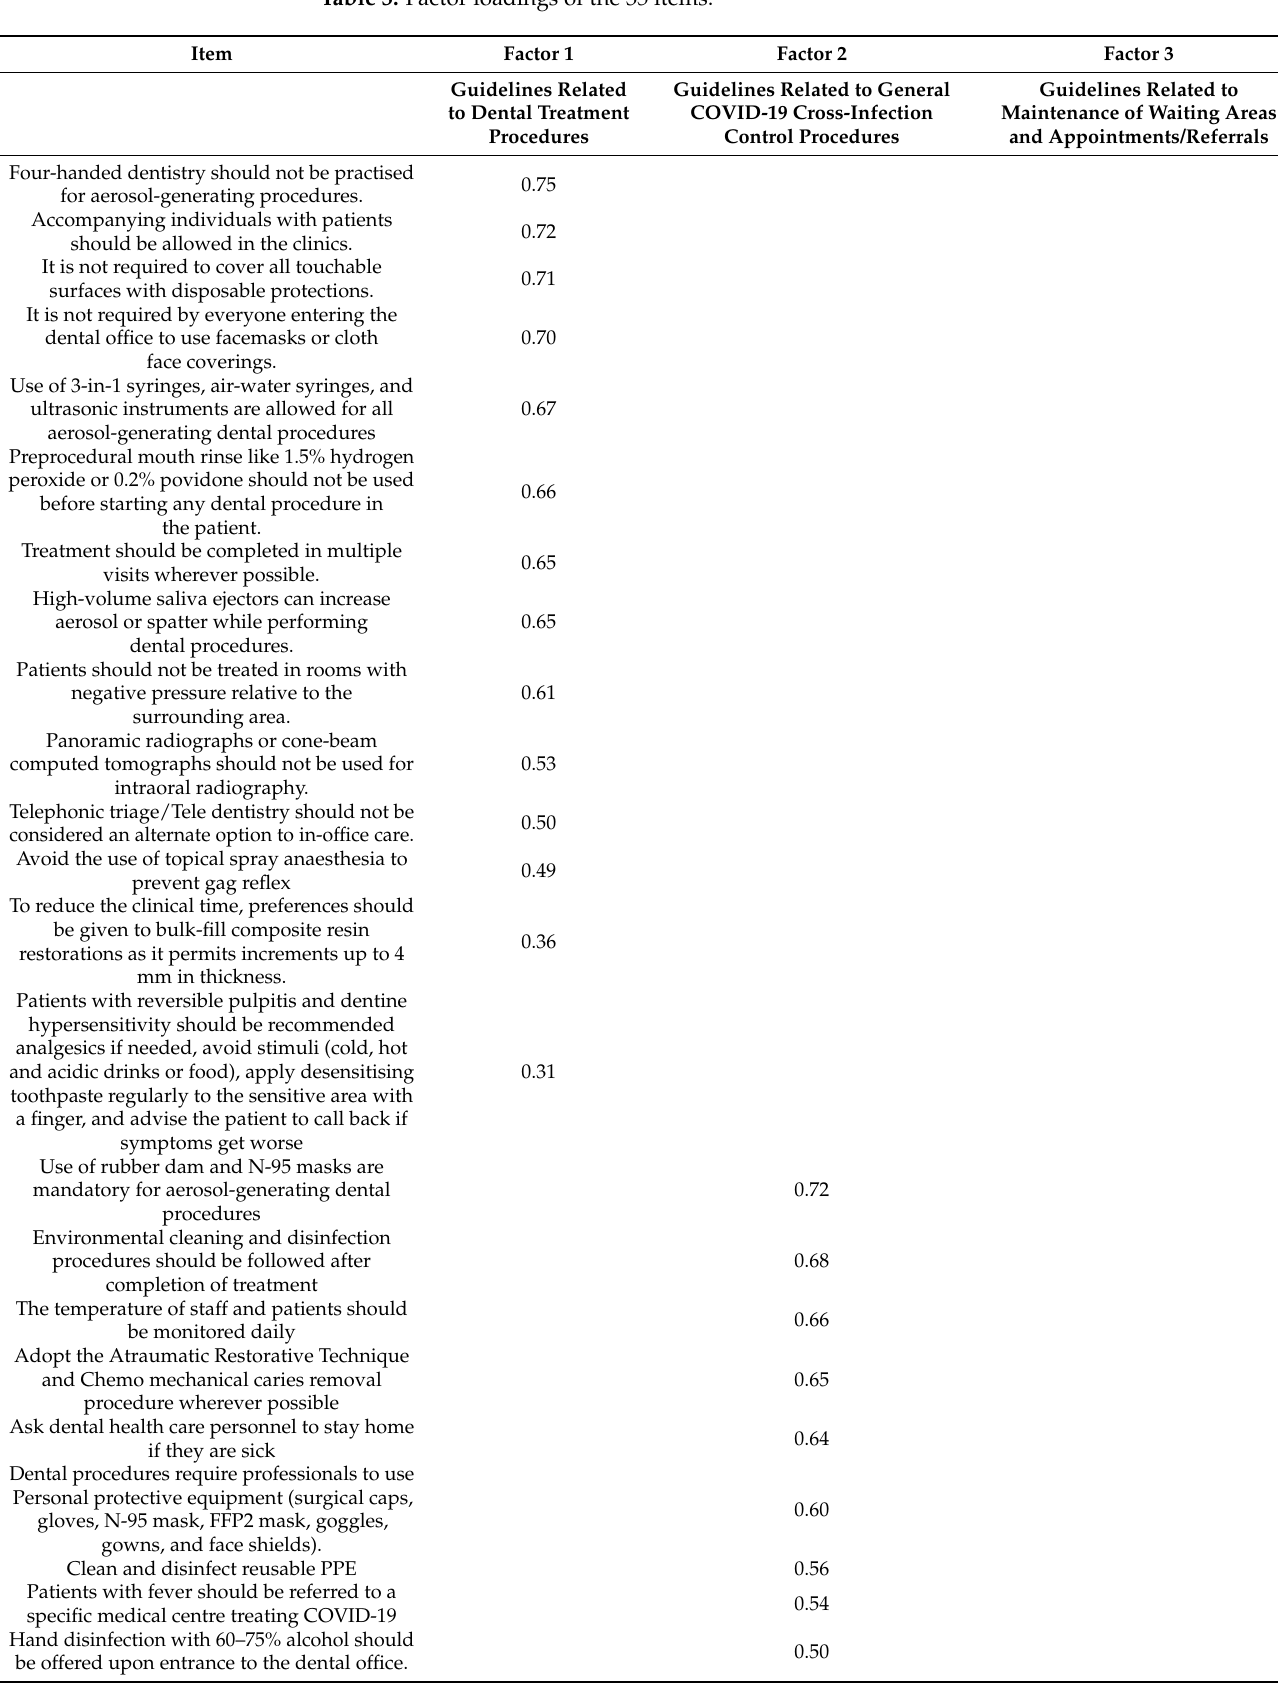
Table 3. Factor loadings of the 35